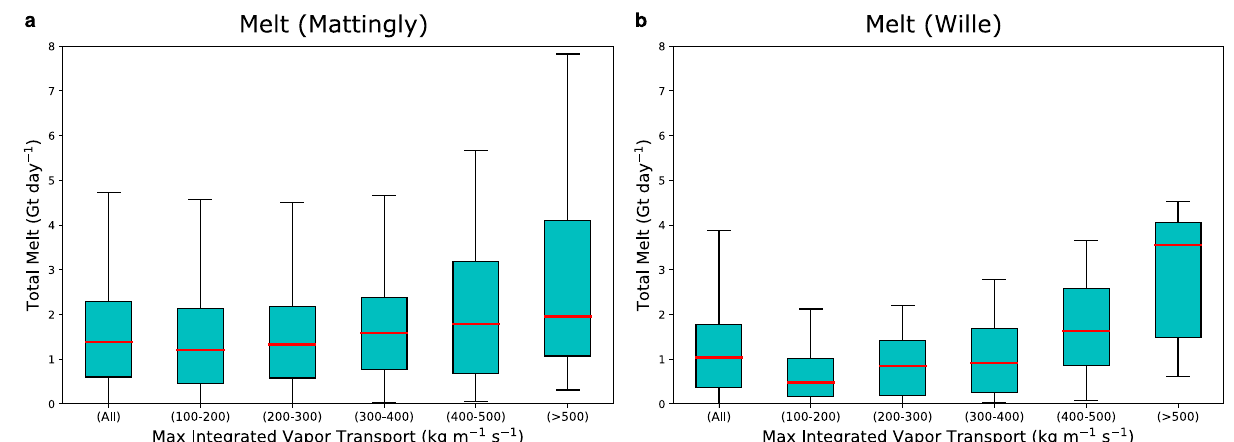
Fig. 3 | Relationship between summer (JJA) atmospheric river (AR) intensity and magnitude of surface melt. Box and whisker plot shows the maximum inte- grated water vapor transport (IVT) of northwest (NW) Greenland landfalling ARs (orange box in Fig. 1a) detected using the algorithm in ( a ) Mattingly et al. 21 and ( b ) Wille et al. 31 and the corresponding daily surface melt 24h after the initial AR landfallsummedoverthenortheast(NE)Greenlanddomain(redboxinFig.1a).The